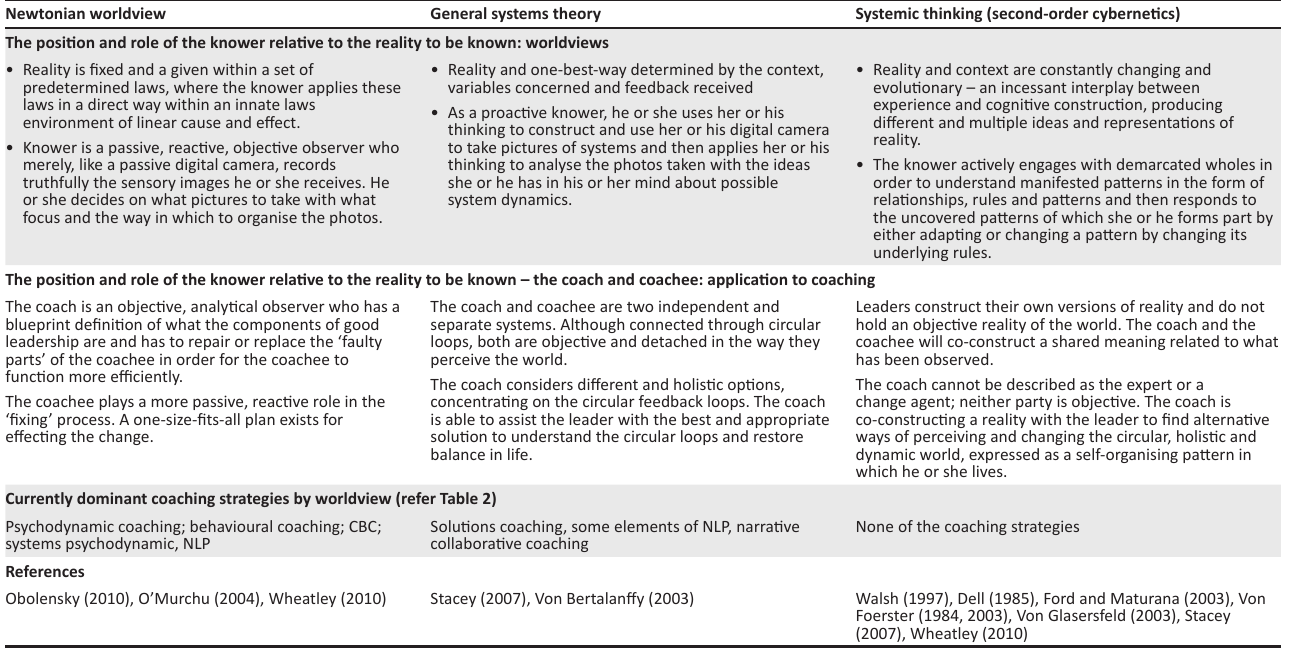
TABLE 5: Position and role of the knower relative to the reality to be known – the coach and coachee: worldviews and application to coaching. Newtonian